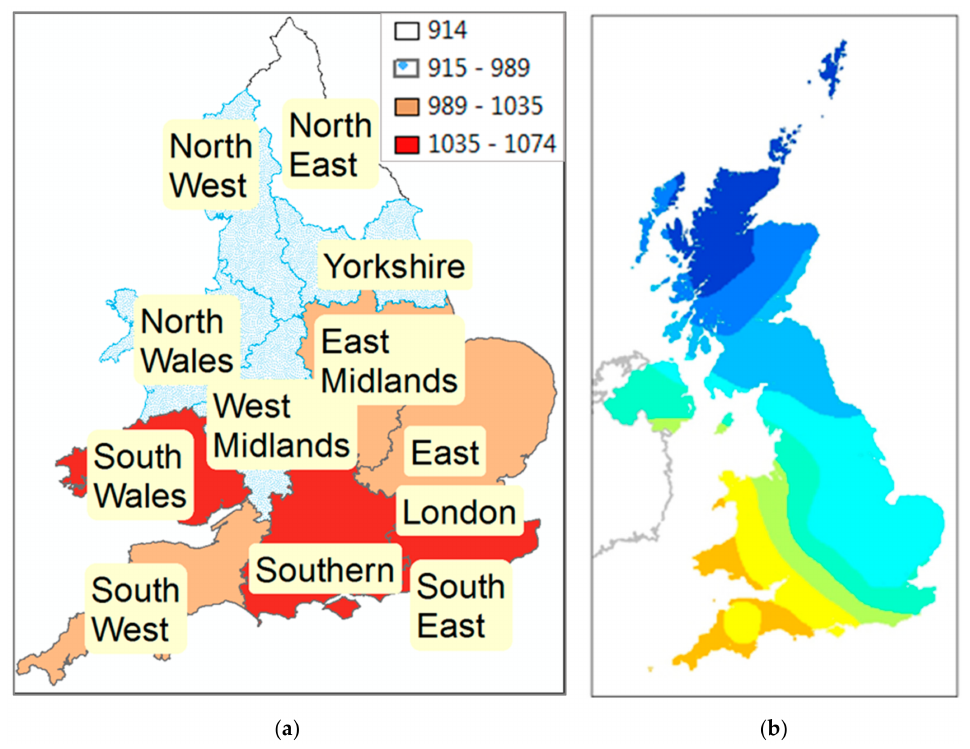
Figure 4. Average annual global horizontal irradiation of each DNO, kWh/m 2 (ten-year average 2005–2014). ( a ) Average annual GHI per DNO, kWh/m 2 ; ( b ) interpolated irradiance (blue = low, orange = high).